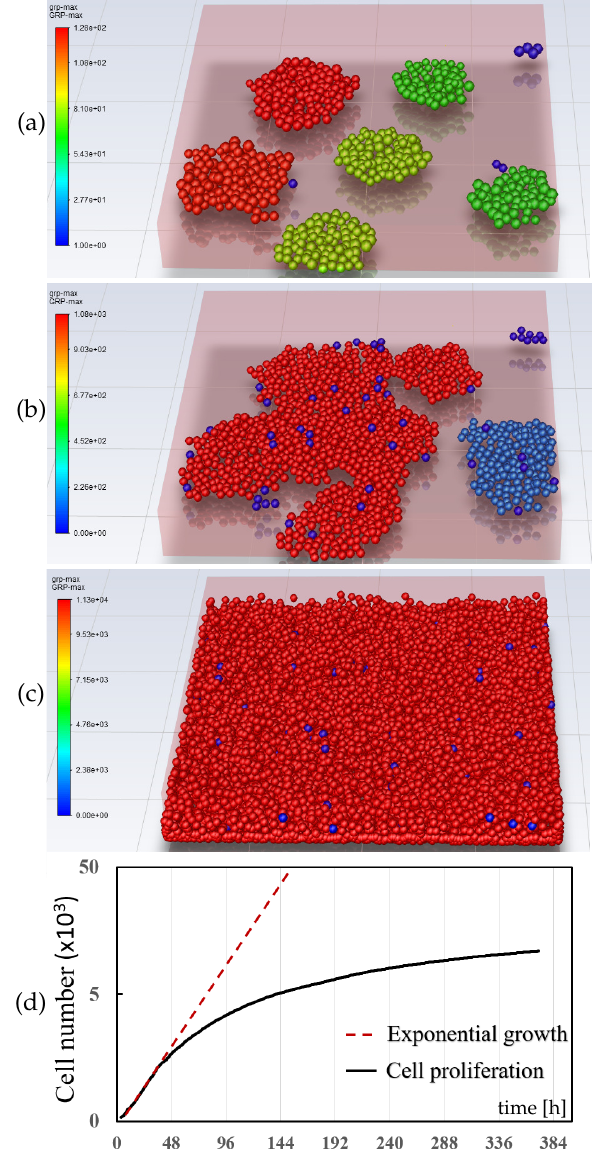
Figure 5. Tumor aggregate growth. ( a ) Initially, cells were randomly distributed into groups of 20–30 cells. ( b ) After 48 h, cell groups merged, and the inner cells of the aggregates lost their ability to proliferate. ( c ) Surface cells continued to proliferate up until 360 h of simulation. ( d ) Cell growth for 360 h of simulation (log scale) (see also Supplementary Material Video